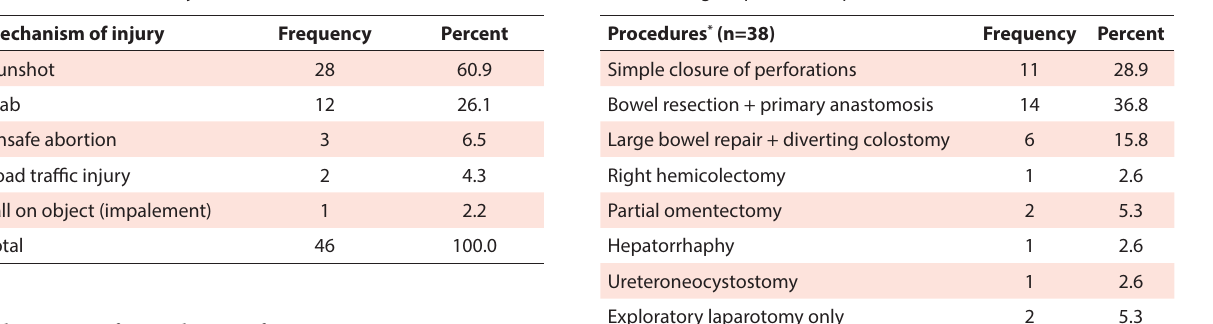
Table 1. Mechanisms of injuries